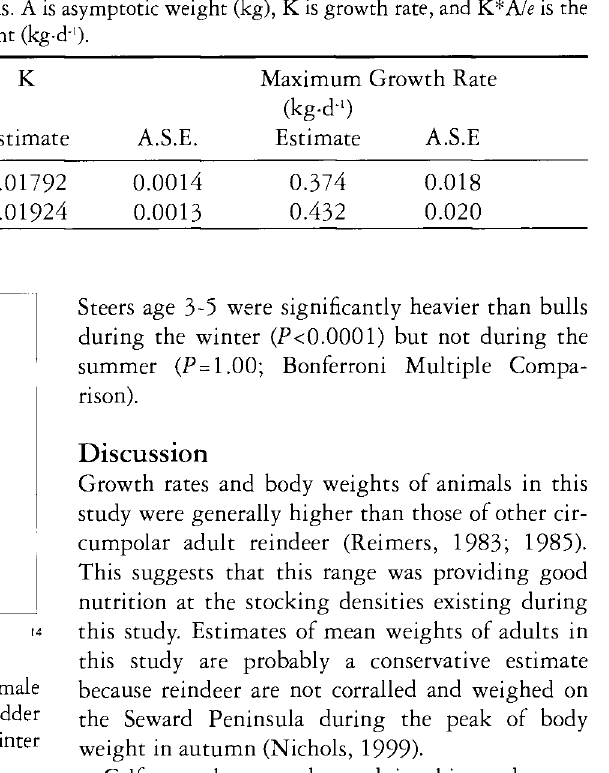
Table 1. Parameter estimates and asymptotic standard errors (A.S.E.) of Gompertz growth curves fit to weight data for reindeer calves from birth to age 8.5 months. A is asymptotic weight (kg), K is growth rate, and K*A/e is the maximum growrh rate at the inflection point (kg-d 1 ).